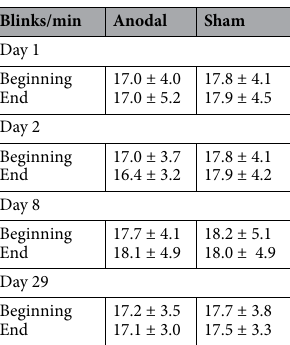
Table 1. Spontaneous blink rates (blinks per minute ± SD) as assessed at the beginning and at the end of each day in the anodal and sham group.